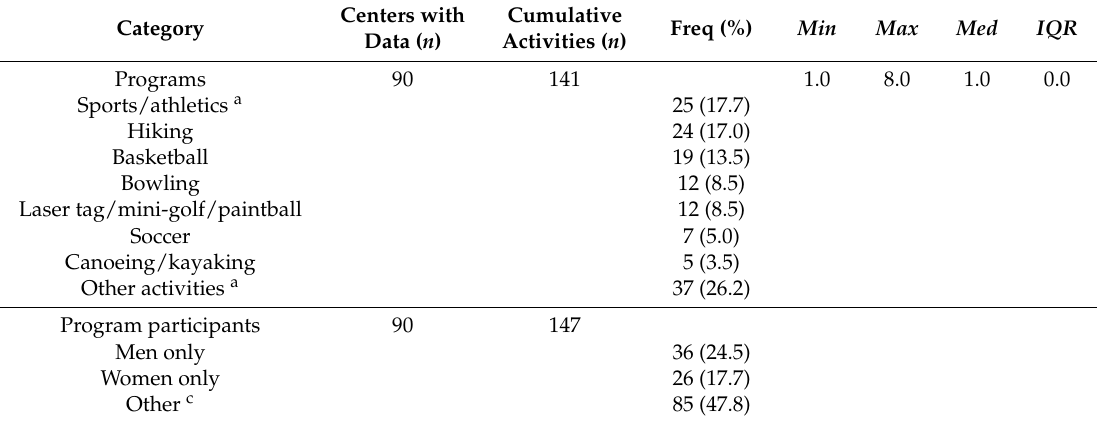
Table 4. Islamic center youth group activity descriptive data ( n = 90